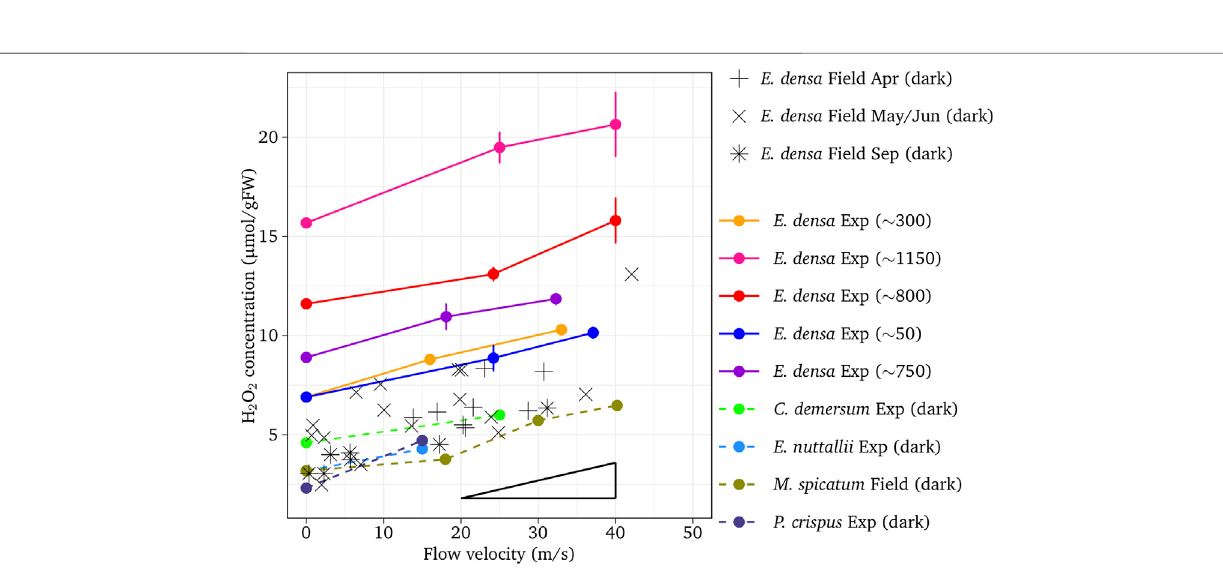
FIGURE 2 | Effect of fl ow velocity on H 2 O 2 concentration with different light intensities or different sampling time. Vertical bars indicate standard deviation. The triangle shows the average gradient. The values in the parentheses are light intensities (µmol/m 2 /s)